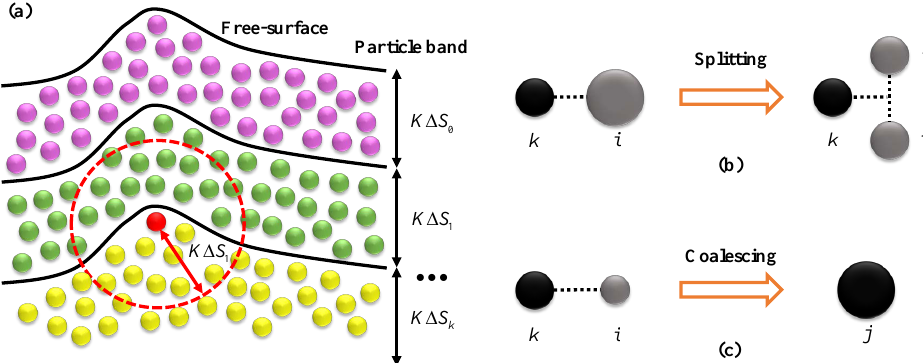
Figure 24. The schematic diagram of Yang’s ASR [246]. ( a ) Several particle bands to characterize the distance to the free-surface particles. ( b ) The principle of particle splitting. ( c ) The principle of particle coalescing.